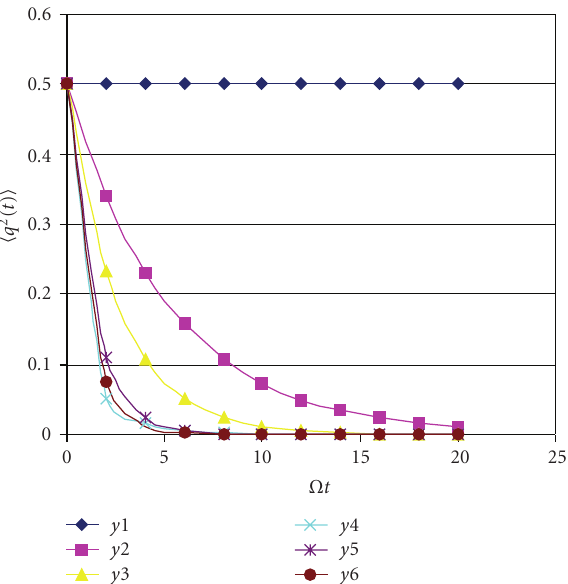
Figure 1: The uncertainties in position for the under-damped oscillator as a function of Ω t are governed by the modified Caldirola-Kanai Hamiltonian with dissipation coe ffi cients γ = 0, 0.2 Ω , 0.4 Ω , 0.6 Ω , 0.8 Ω , and Ω , respectively.